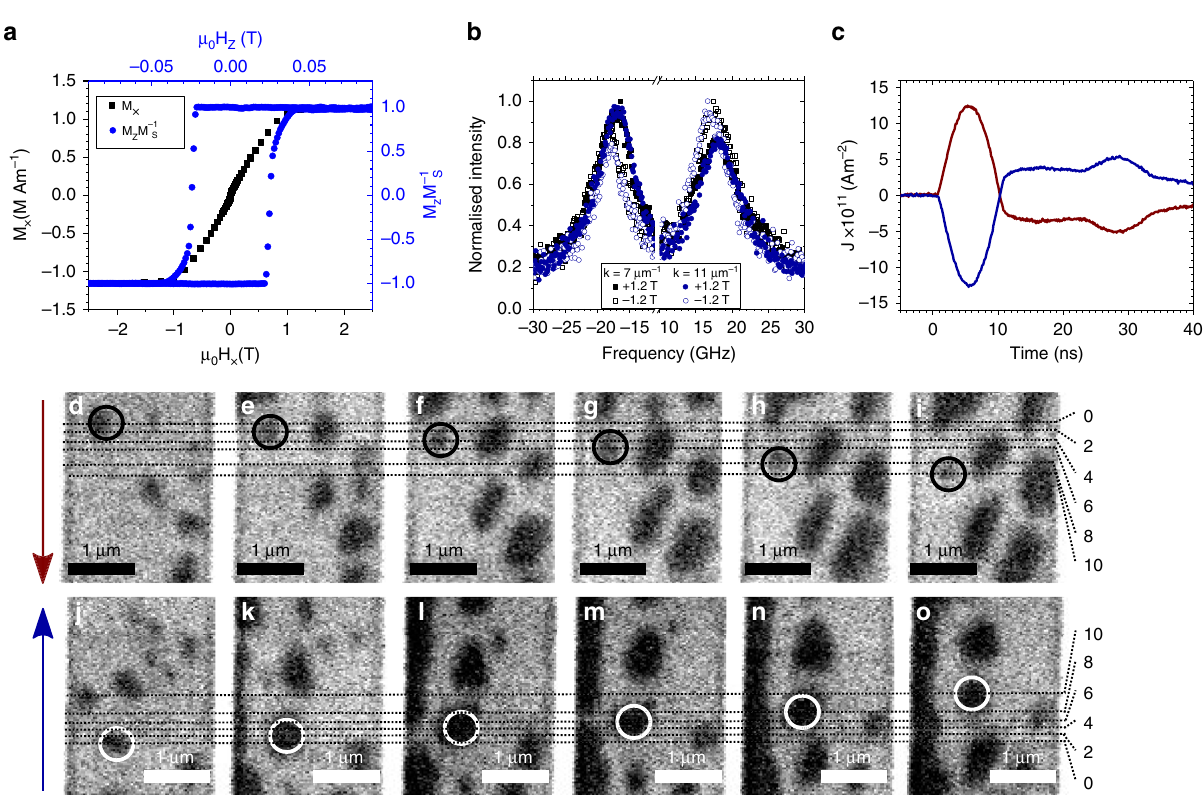
Fig. 1 Zero fi eld skyrmion motion. Skyrmion motion was observed in a 2 µ m wide Ta(3.2)/Pt(2.7)/[CoB (0.8)/Ir (0.4)/Pt (0.6)] ×5 /Pt (2.2) multilayer wire (thickness in nm) in 0 mT applied fi eld. a Magnetisation, M x , versus in-plane ( μ 0 H x ) and normalised magnetisation M z M − 1 S versus out-of-plane ( μ 0 H z ) fi eld measured on a multilayer fi lm using SQUID vibrating sample magnetometry and MOKE magnetometry. The saturation magnetisation, M S was measured to be 1.2 ± 0.1 MAm − 1 . b Brillouin light scattering was used to measure the DMI strength, D , of a multilayer fi lm. D was extracted from the asymmetry of the Stokes and anti-Stokes lines due to inelastically scattering of the incident light from the propagating spin waves with magnon wavevector, and was found to be − 1.1 ± 0.1 mJm − 2 . c Time-trace of a positive (red) and negative (blue) current pulse applied through the wire. d – i Single helicity STXM images after two consecutive 9-ns-long current pulses with current densities of J = 1.2 × 10 12 Am − 2 applied along the direction of the red arrow (positive current) and j – o along the blue arrow (negative current). The dashed lines track the vertical position of the skyrmion centre throughout the pulse sequence. An average skyrmion velocity of 8 ± 3 ms − 1 was observed in this sequence of increased. This is expected as the fi eld polarity was chosen to decreases. This was seen to be due to an increase of the number of apply a radial shrinking force on the skyrmions 28 . respectively. After the fi rst four current pulses the 0 mT data shows that all 16 skyrmions are intact, whereas, at − 4 mT only 12 skyrmions remained.